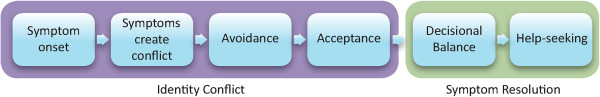
The progression of themes over time.